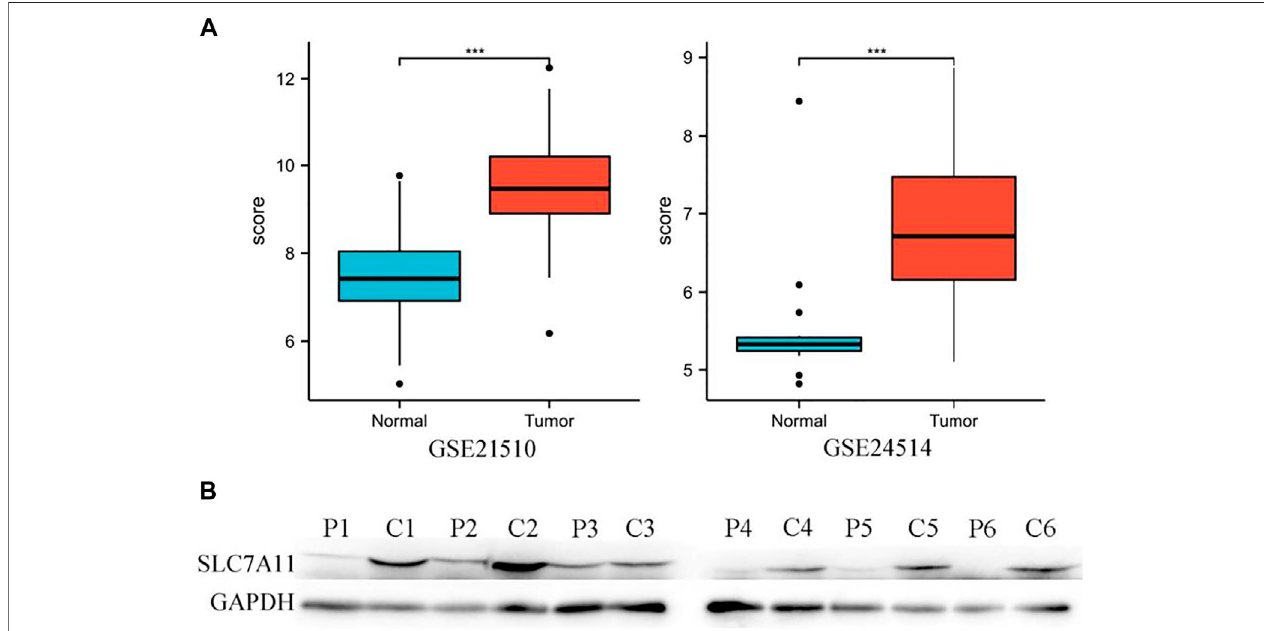
FIGURE 2 | High expression of SLC7A11 in colon cancer. (A) Analysis of SLC7A11 gene expression in GEO datasets, n (normal) = 25 and n (tumor) = 123 in GSE21510, n (normal) = 15 and n (tumor) = 34 in GSE24514. *** p < 0.001. (B) Expression levels of SLC7A11 were detected by Western blot analysis, P1-6: paracancerous tissues of patients 1 – 6, C1-6: cancer tissues of patients 1 – 6, the bands gray value of C1-6 signi fi cantly higher than the P1-6 ( p < 0.01). Correlation analysis between SLC7A11 expression and in fi ltrating immune cells.